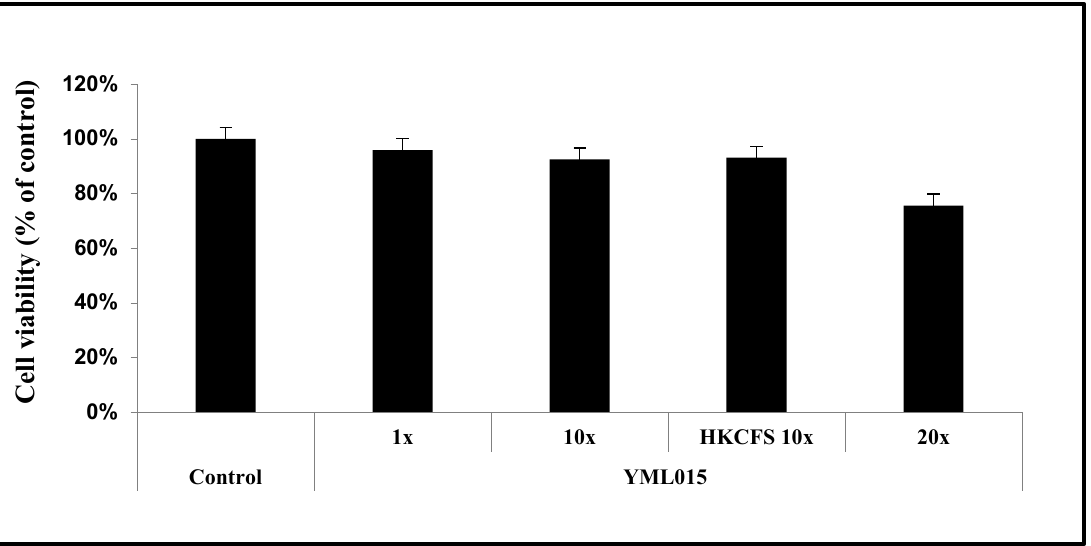
Figure 4. Effect of L. plantarum YML015 in different concentrations (CFS 1x, CFS 10x, HKCFS 10x, and CFS 20x) on MTT cell viability assay in MDCK cells with LPS induced. Cell viability was measured using the MTT method. Each determination was made in triplicate and less 5% of standard deviation error.